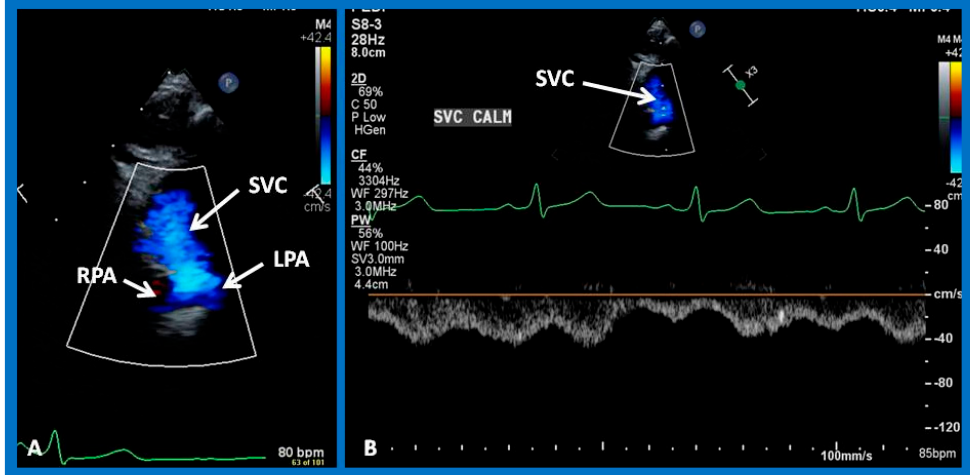
Figure 5. Selected video images from the suprasternal notch view demonstrating bidirectional Glenn anastomosis. The superior vena cava (SVC) emptying into the left (LPA) and right (RPA) pulmonary arteries by color flow imaging ( A ). Normal Doppler flow velocities across the Glenn shunt ( B ) suggests that the anastomotic site is not occluded. Reproduced from [21].